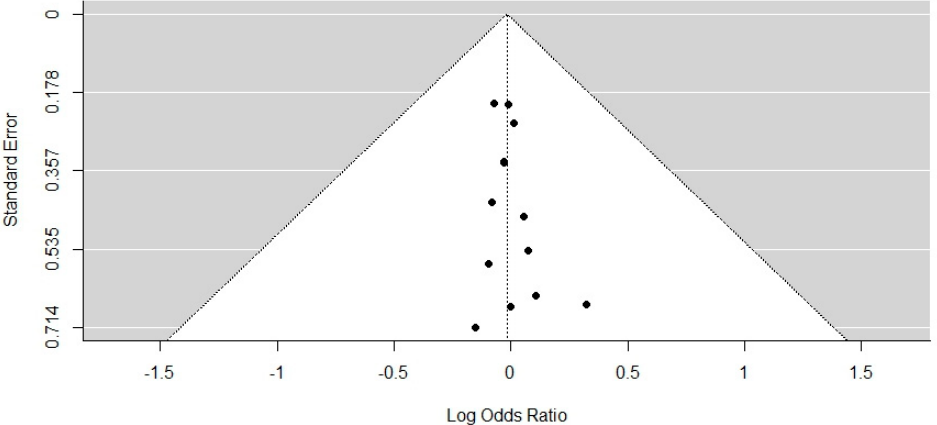
Figure 4. Funnel plot of the included studies.